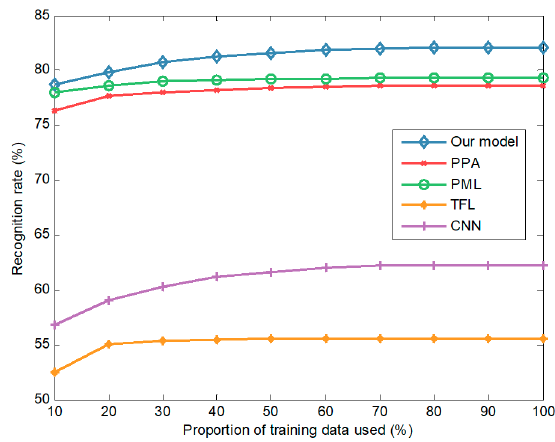
Figure 9. The recognition rates of different methods at a depression angle of 45°.